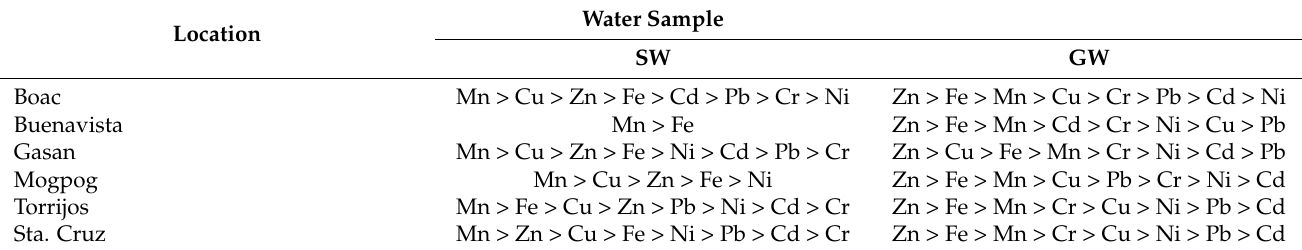
Table 4. Trend of metal concentration accumulation in water across the